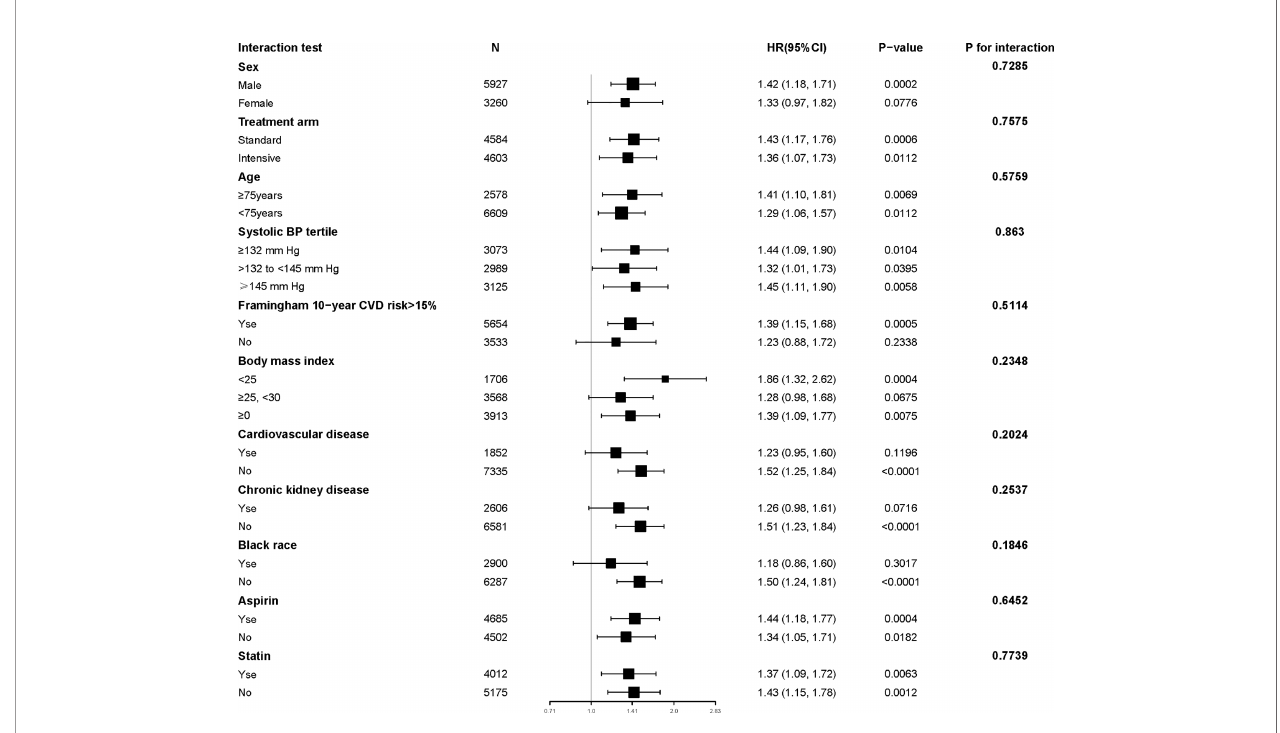
FIGURE 2 | Subgroup analysis of the relationship between Tyg index and